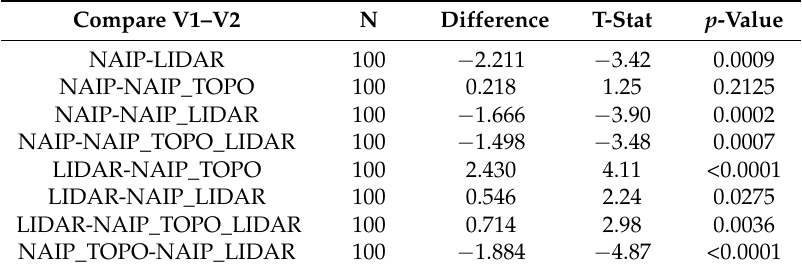
Table A4. BAH paired comparisons between models developed from combinations of NAIP, LiDAR and Topo data sources.